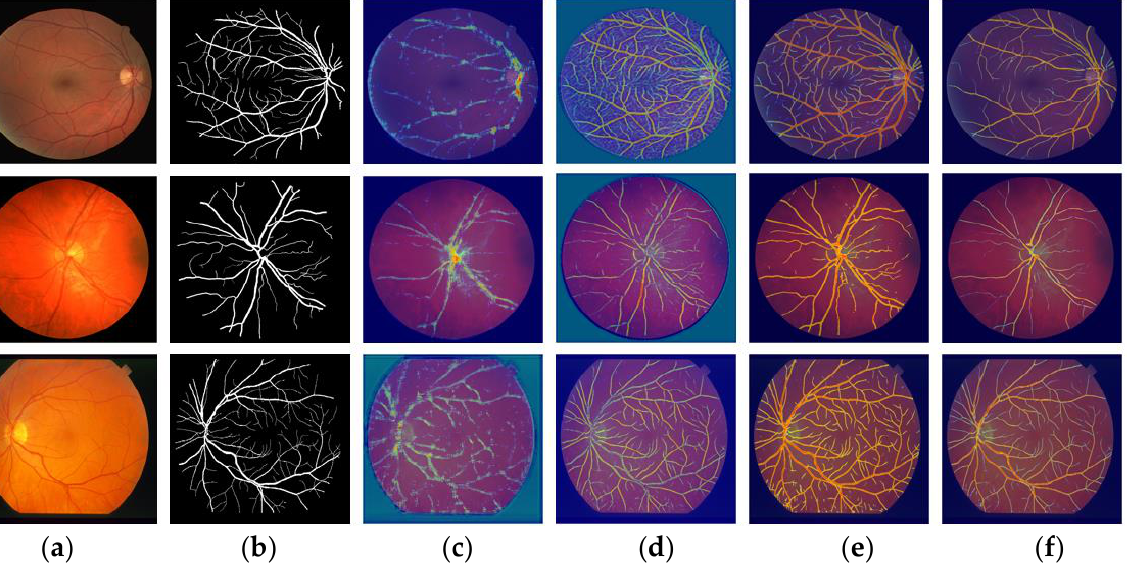
Figure 11. VSUL-Net Grad-cam visualization for the DRIVE (row-1), CHASE-DB1 (row-2), and STARE datasets (row-3): ( a ) original fundus image, ( b ) expert annotation, and Grad-cam extracted from the ReLU of ( c ) T-Conv-BB-A, ( d ) DW-Sep-Conv-RT-A, ( e ) T-Conv-US-A, ( f ) Class-Mask-Conv of Table 3.